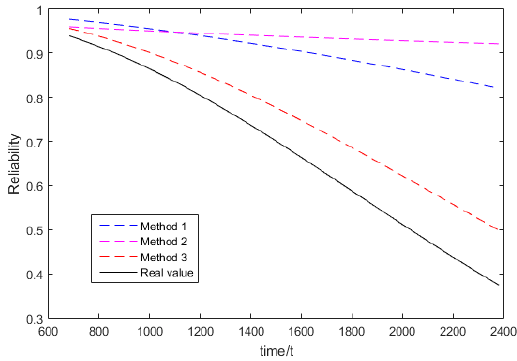
Figure 1. Reliability comparison.